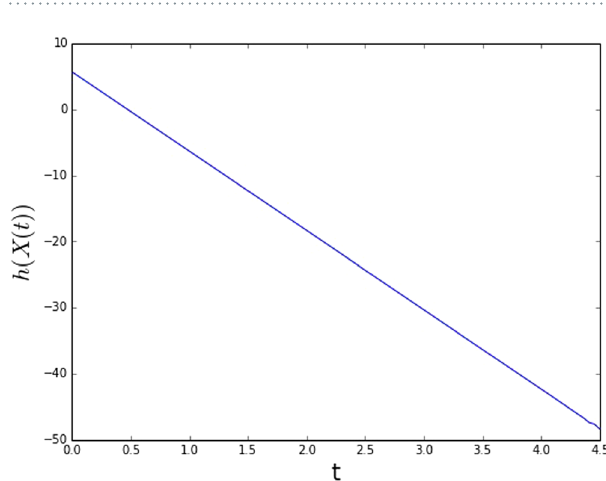
Figure 2. The evolution of network entropy for quantum network